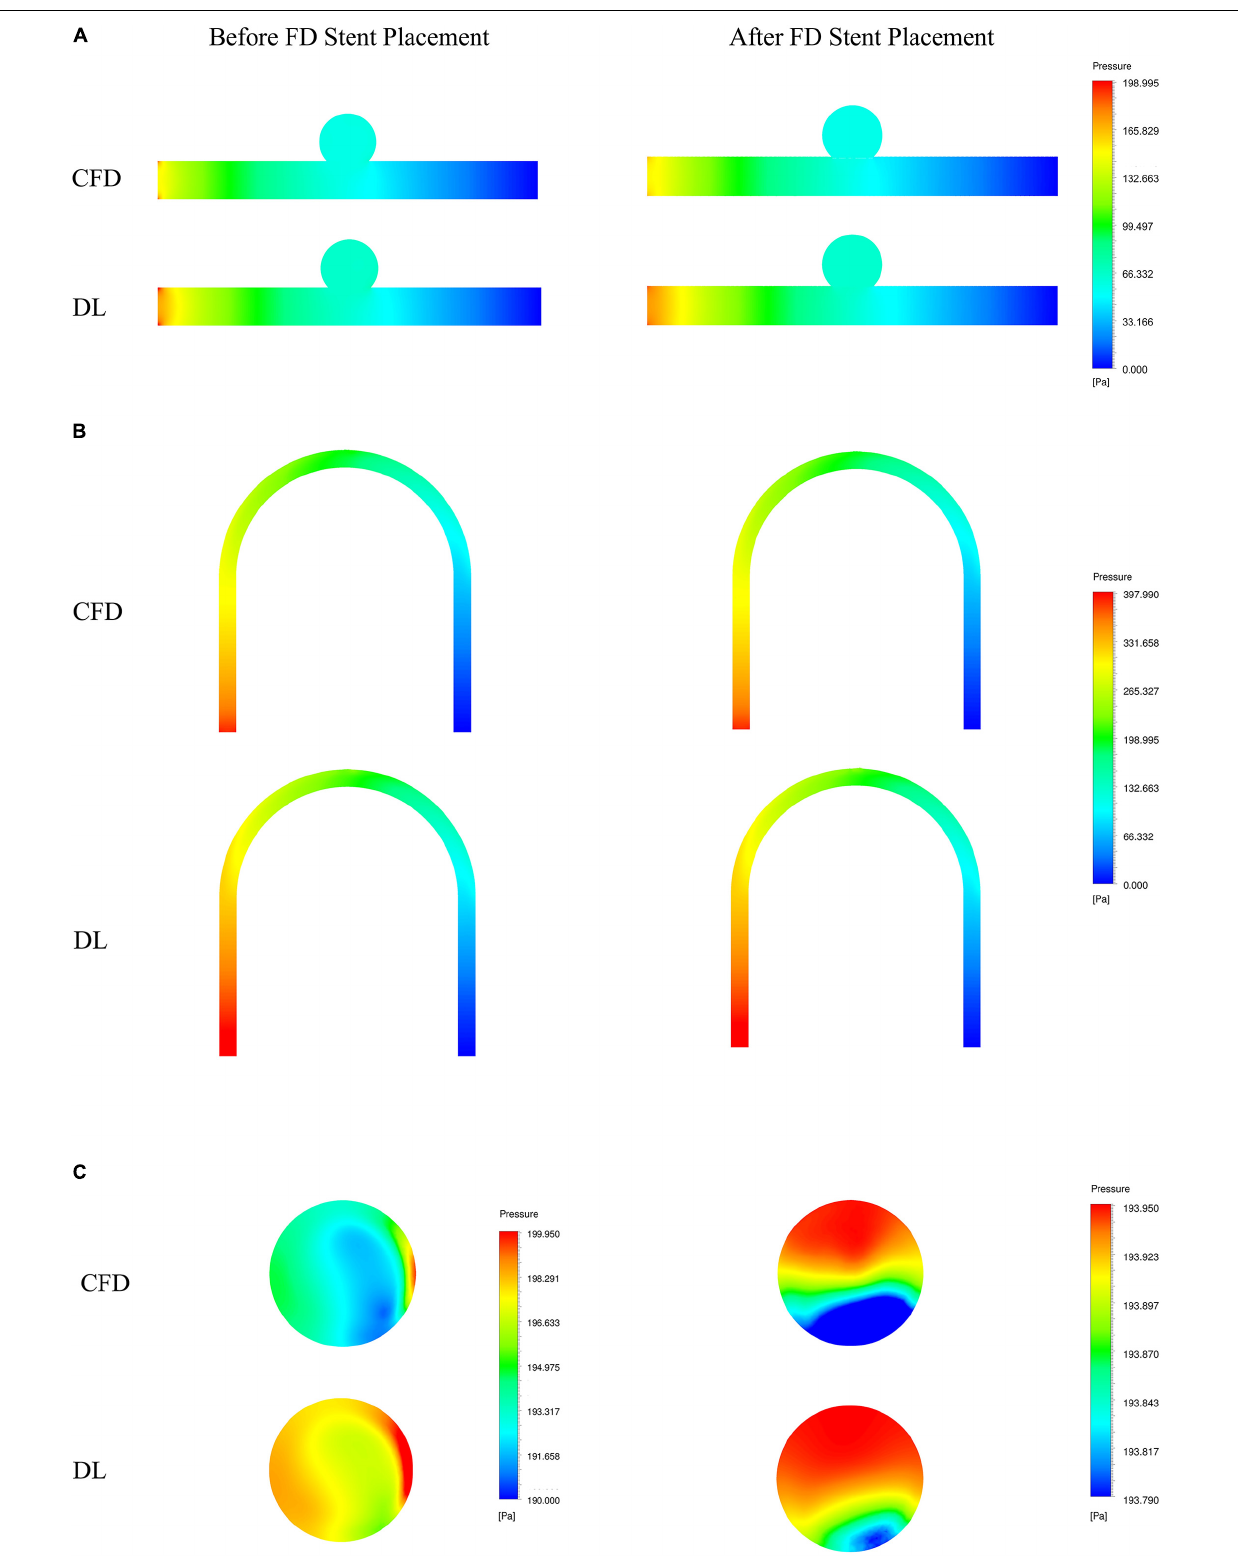
Frontiers in Physiology |